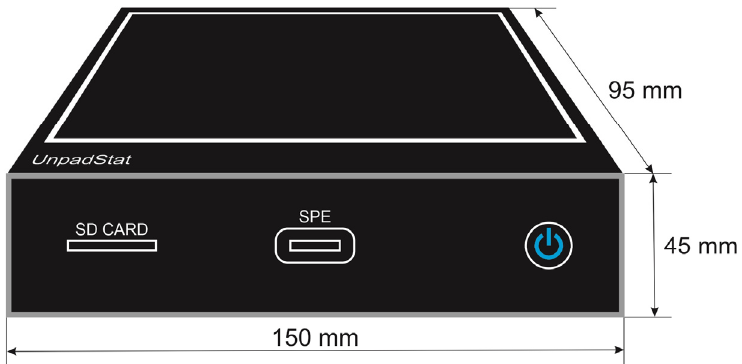
Figure 5. Casing design.